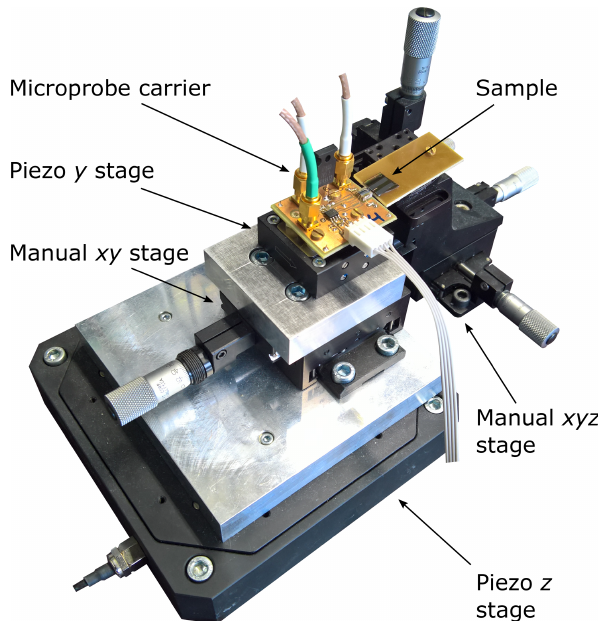
Figure 4. Photograph of the homemade positioning and scanning table with a microprobe carrier PCB mounted on top. The tip of the probe is in contact with the surface of a sample, which is mounted on a manual xyz